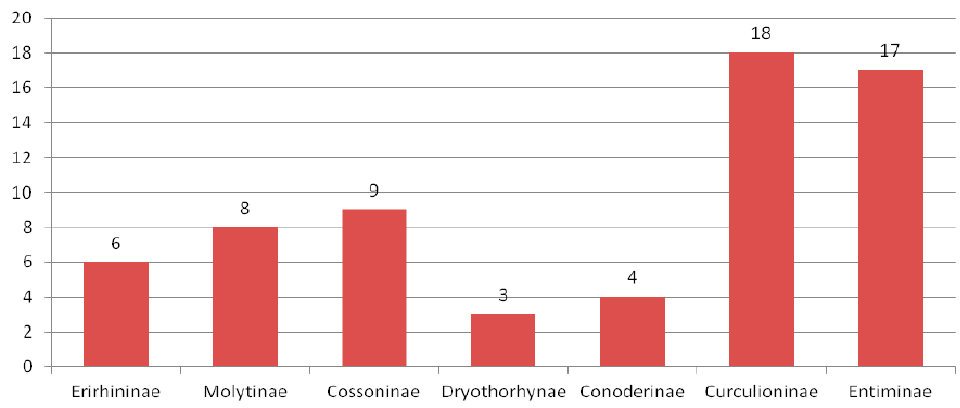
Figure 18. Change in the number of Curculionoidea species in the Eocene. Figure 19. Change in the number of Curculionoidea species in the Eocene.